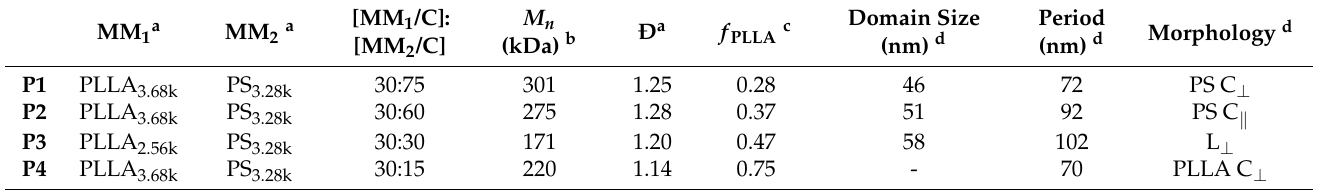
Table 2. Characteristics of PLLA- b -PS BBCPs synthesized and studied in this work.